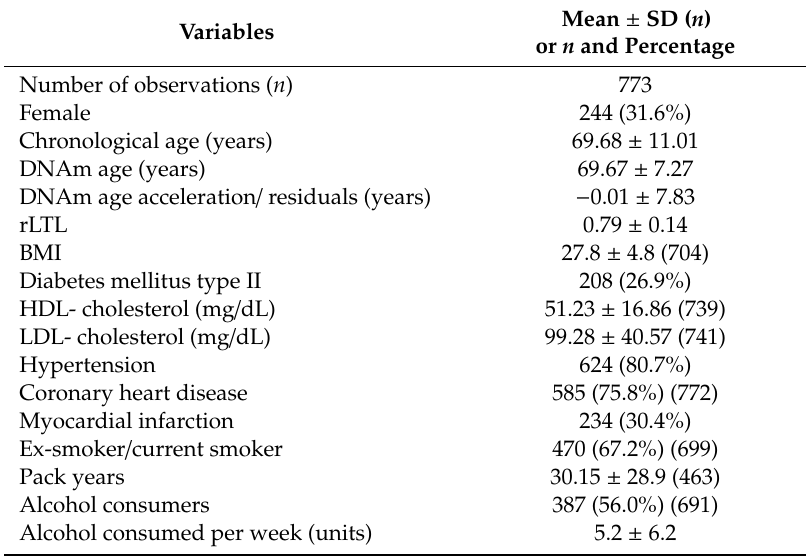
Table 1. Characteristics of the LipidCardio participants for whom data on relative leukocyte telomere length (rLTL), DNA methylation (DNAm) age, and DNAm age acceleration were available ( n = 773) (SD: standard deviation, n : number of observations, rLTL: relative leukocyte telomere length, BMI: body mass index, HDL-C: high density lipoprotein cholesterol, LDL-C: low density lipoprotein cholesterol, mg / dL: milligrams per